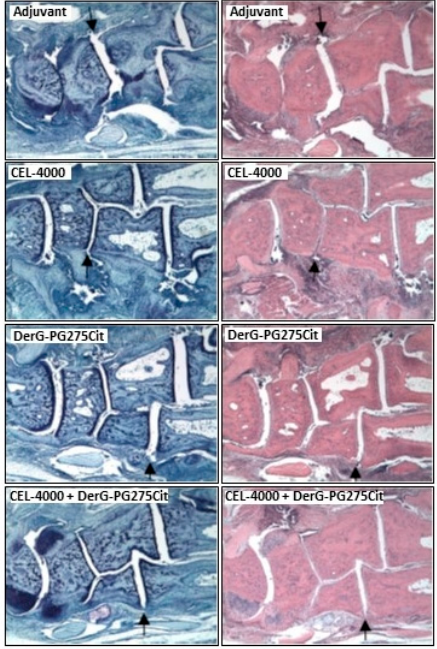
Figure 3. Representative histopathology images of ankles and foot joints of mice from the introductory study (Study 1). Adjacent tissue sections of ankles and midfoot joints from adjuvant-treated control or LEAPS vaccine treated GIA mice were stained with toluidine blue (TB, left-side images) or hematoxylin and eosin (H&E, right-side images). TB staining is well suited to joint sections, as it depicts matrix loss from damaged cartilage, and bone resorption (lighter than normal staining) as well as periosteal bone formation (darker than normal staining). TB-stained sections can also be assessed for inflammation, pannus formation and overall tissue damage. However, H&E staining captures inflammation (leukocyte infiltration) better than TB. The sections from the adjuvant-treated animal show marked inflammation, moderate cartilage damage, mild pannus and bone resorption as well as severe periosteal bone formation. The animal vaccinated with CEL-4000 displays moderate inflammation and mild cartilage damage in one joint only. The sections from a DerG-PG275Cit-treated animal show moderate inflammation and mild cartilage damage in several joints. The animal treated with the combination of CEL-4000 and DerG-PG275Cit demonstrates mild inflammation and cartilage damage, mild pannus and bone resorption as well as moderate periosteal bone formation in a single joint. A black arrow points to a pathological change in each of the joint sections. Inflammatory and structural damages were the most widespread in the joints of the adjuvant-treated control mouse. Original magnification: 40x.